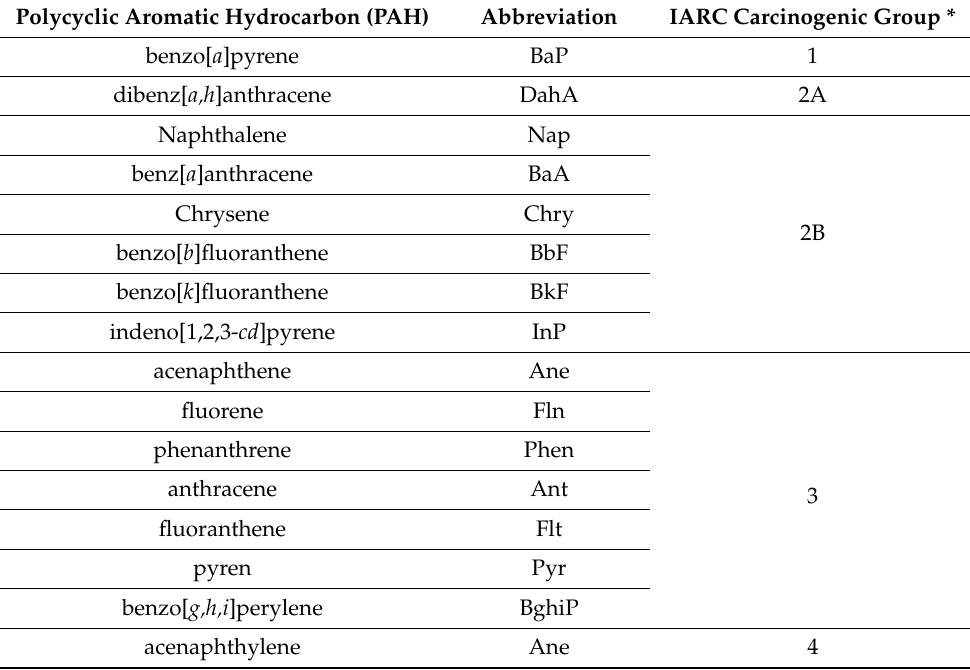
Table 1. Evaluation of the polycyclic aromatic hydrocarbons, according to IARC [32]. Polycyclic Aromatic Hydrocarbon